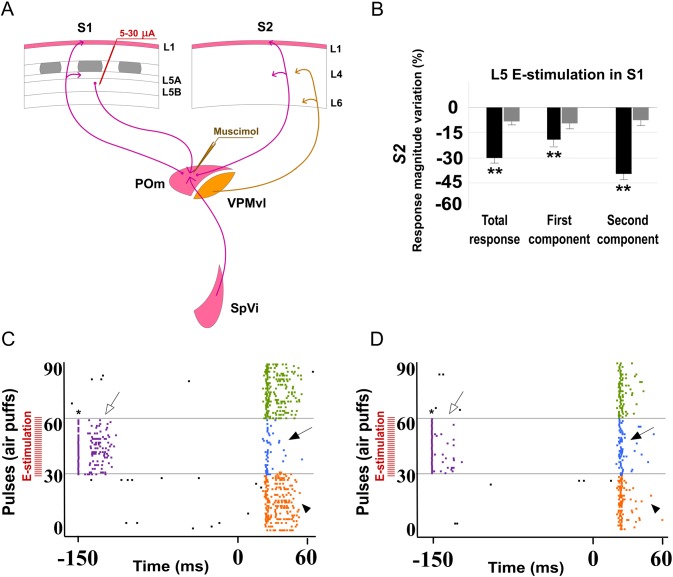
L5 E-stimulation in S1 does not modulate sensory responses in S2 when POm is inactivated.(A) Schematic diagram summarizing the corticothalamocortical circuitry from S1 to S2 through the POm and the extralemniscal pathway to S2 from the VPMvl thalamic nucleus. The experimental manipulation of the barrel cortex and POm is also shown. (B) Change (%) in mean S2 sensory response magnitude by stimulating L5 of S1 before (black) and after POm muscimol inactivation (gray). L5 E-stimulation in S1 did not reduce significantly sensory response spikes in S2 when POm was inactivated. ** P<0.001. (C) Sensory responses in S2 were reduced when we applied E-stimulation in L5 of S1 before each stimulus (filled arrows). This effect was abolished when the POm was inactivated with muscimol (D). Control condition before (orange) and after (green) POm E-stimulation condition (blue) are shown. E-stimulation was applied 150 ms before pulses 31 to 60. Spikes evoked in S2 by E-stimulation of L5 in S1 were eliminated by POm inactivation (open arrows). At the stimulation intensities used in this experiment, we have not observed antidromic activation in S2. Sensory responses were significantly decreased after muscimol application but not totally eliminated. Only spikes in the second component of the response were abolished (arrowheads). Spikes in the first component were not reduced by POm inactivation. * indicates stimulation artifacts.